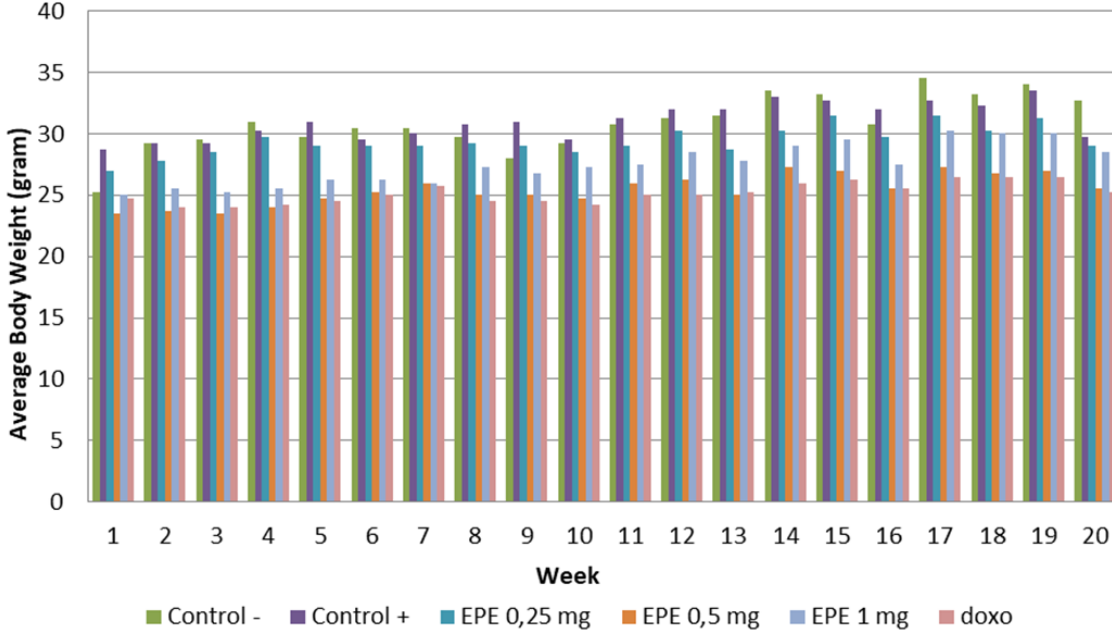
Figure 2. The graph of average body weight in BALB/c mice of the CAC model. (green bar) Negative control, (purple bar) Positive control (blue bar) EPE 0.25 mg/20gBW, (orange bar) EPE 0.50 mg/20gBW, (grey bar) EPE 1.00 mg/20gBW, and (peach bar) Doxorubicin 0.052 mg/20gBW. Weight measurement is carried out every week on all mice each group. Bodyweight range from 1 st to 20 th week was